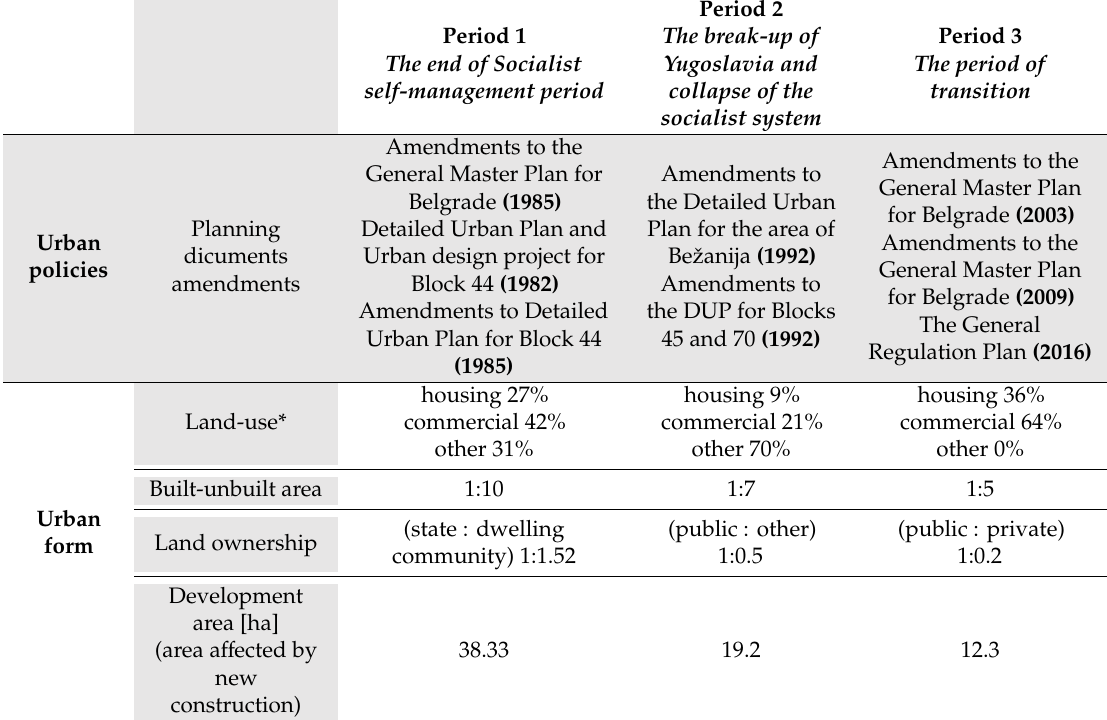
Table 1. The size of consequences, as determined by each planning system (Source: